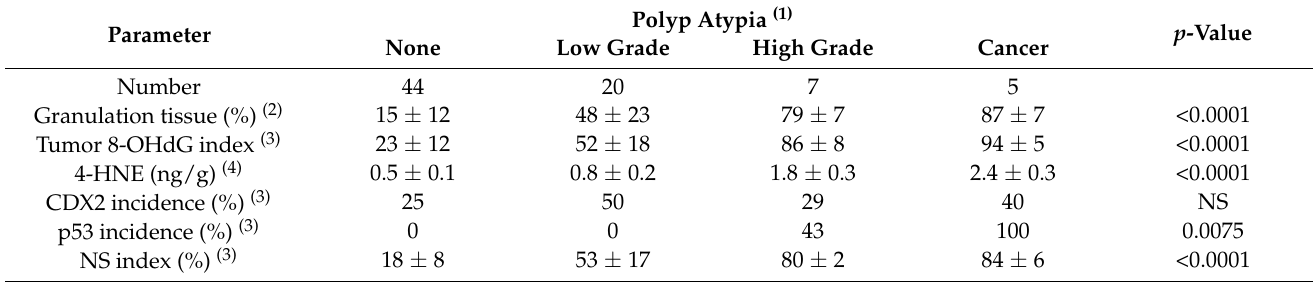
Table 2. Relationship between atypia and granulation tissue, oxidative stress, or